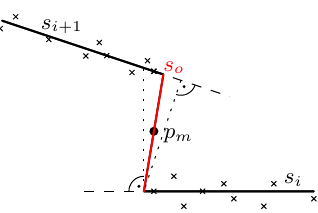
Figure 4: Determination of the distance d o between two nearly parallel consecutive line segments s i and s i +1 based on the midpoint p m between the endpoints of the line